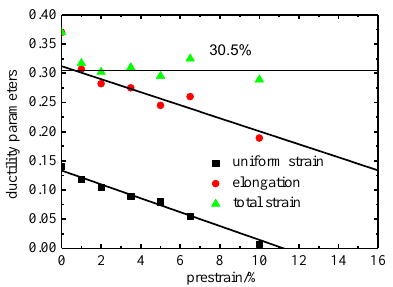
Figure 7. Variation of ductility parameters with amount of prestrain.